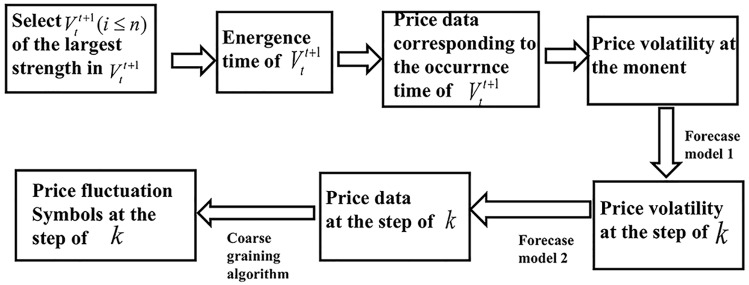
An idea flow chart.